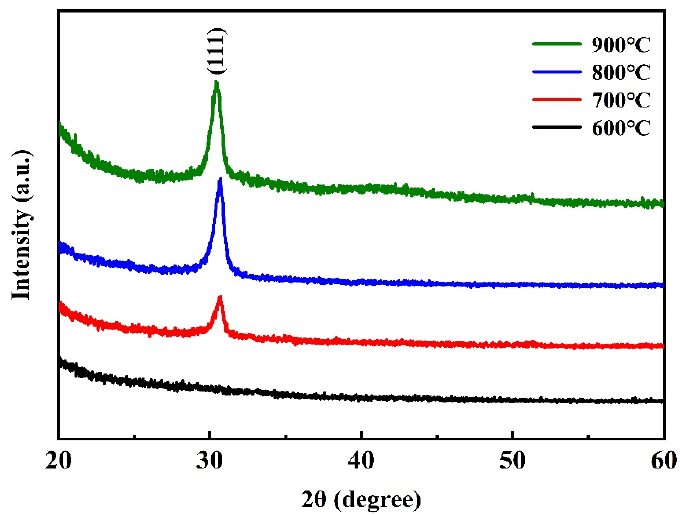
Figure 2. XRD patterns of AZO films at different annealing temperatures.